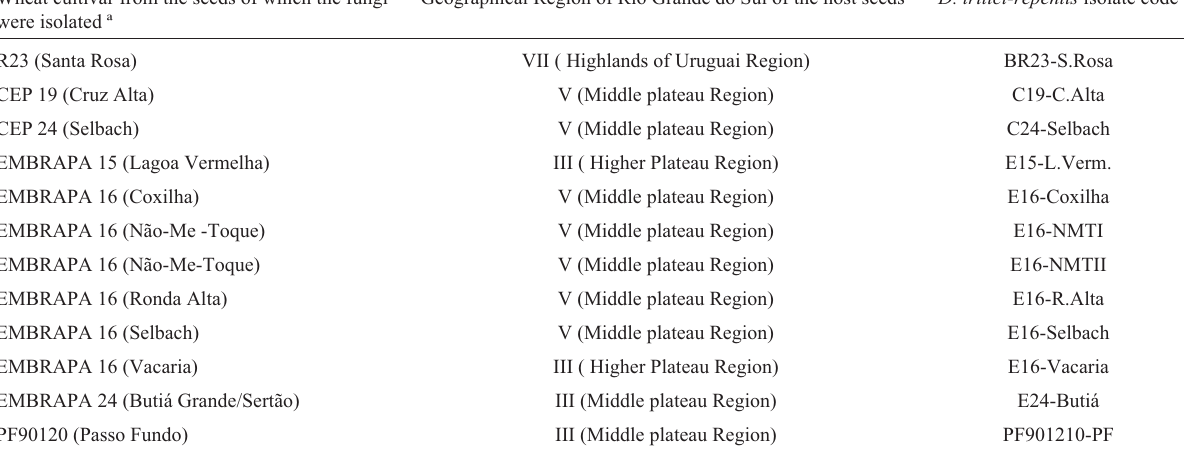
Geographical Region of Rio Grande do Sul of the host seeds b